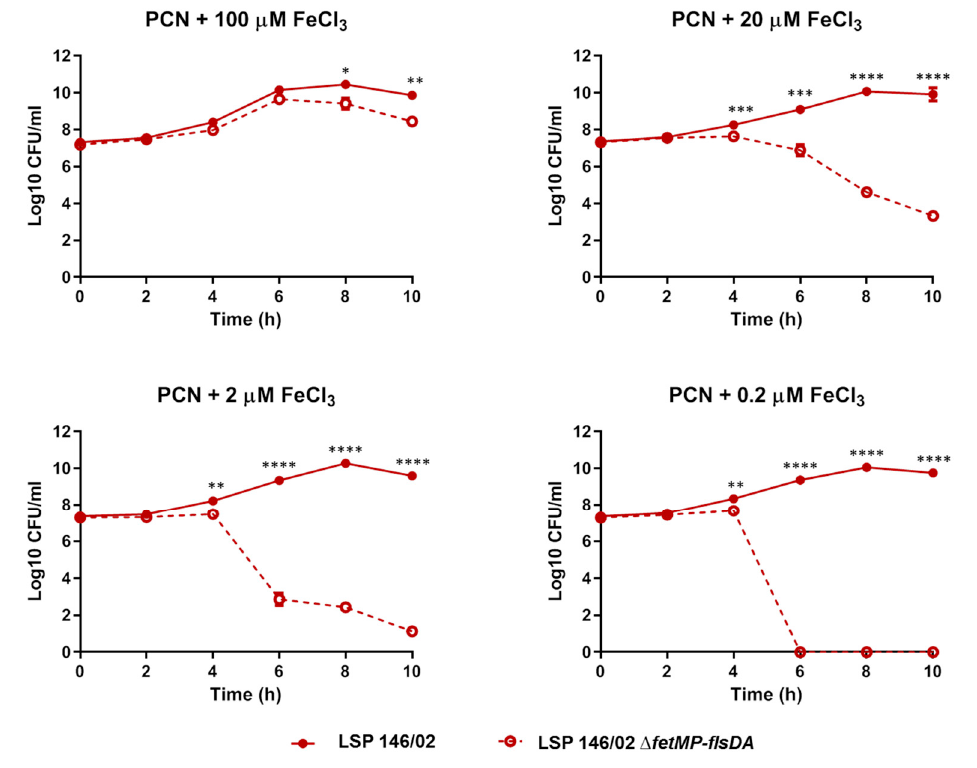
Figure 4. Competition assays of the S. Typhimurium LSP 146 / 02 wild-type strain and its isogenic derivative Δ fetMP - flsDA using a PCN medium with different concentrations of FeCl 3 . The data shown are the mean values ± standard deviations of three biological replicates. Statistical significance (**** p < 0.0001; *** p < 0.001; ** p < 0.01; * p < 0.05) was determined using a one-sample t -test at each time point tested.